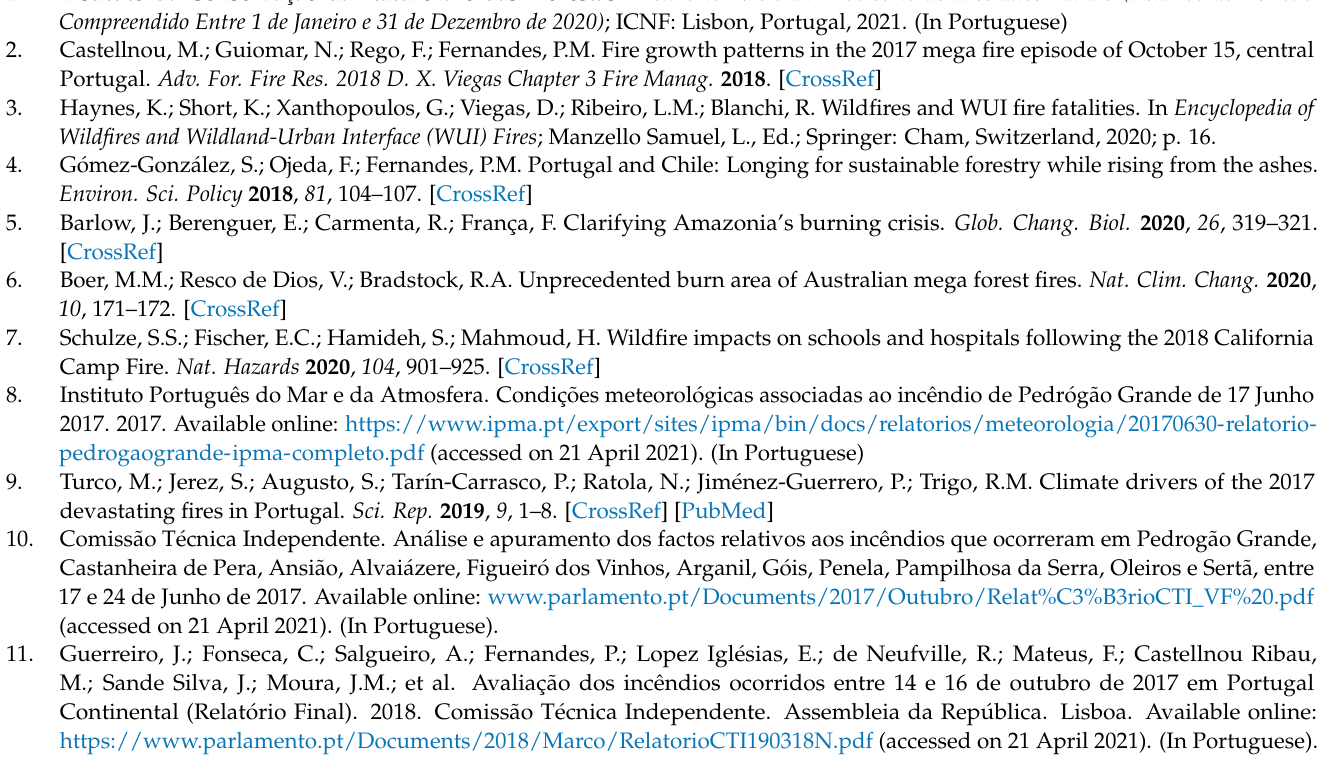
Figure A4. Comparison between simulated fire size with and without integrating uncertainty in fuels. Each pixel reflects the number of simulated wildfires (in logarithmic scale). The dashed line is the 1:1 line.